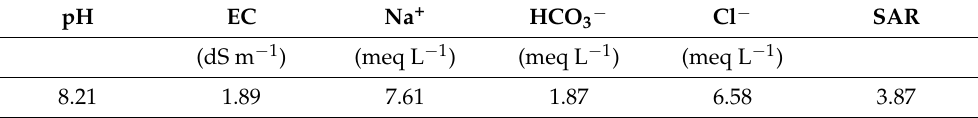
Table 2. Physicochemical characteristics of the irrigation water used in the experiment. pH EC Na + HCO 3